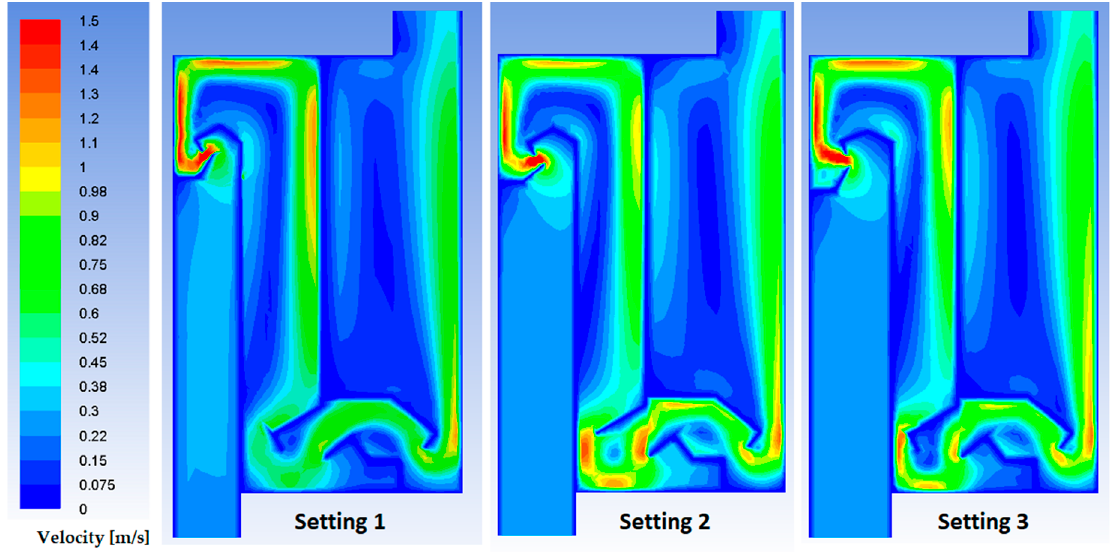
Figure 5. The velocity distribution based on the CFD.